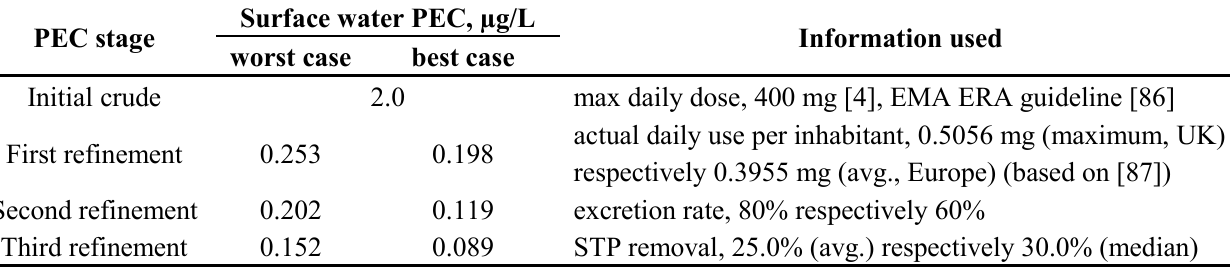
Table 1. Surface Water predicted environmental concentrations (PECs) and their Refinement for TMP in